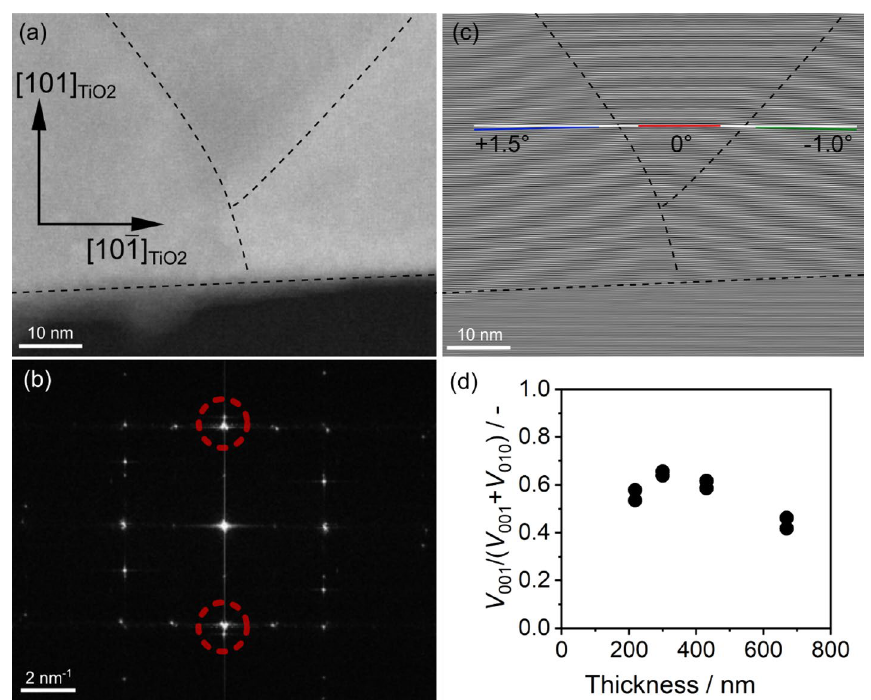
Figure 3. HAADF-STEM for 300 nm-thick BSO/(101)TiO 2 ( a ) a HAADF-STEM image; ( b ) the FFT image of ( a ); and ( c ) the inverse FFT image reconstructed using the spots marked by red circles in ( b ). ( d ) The thickness dependence on the volume fraction of (001)-oriented domains, calculated from locking curve